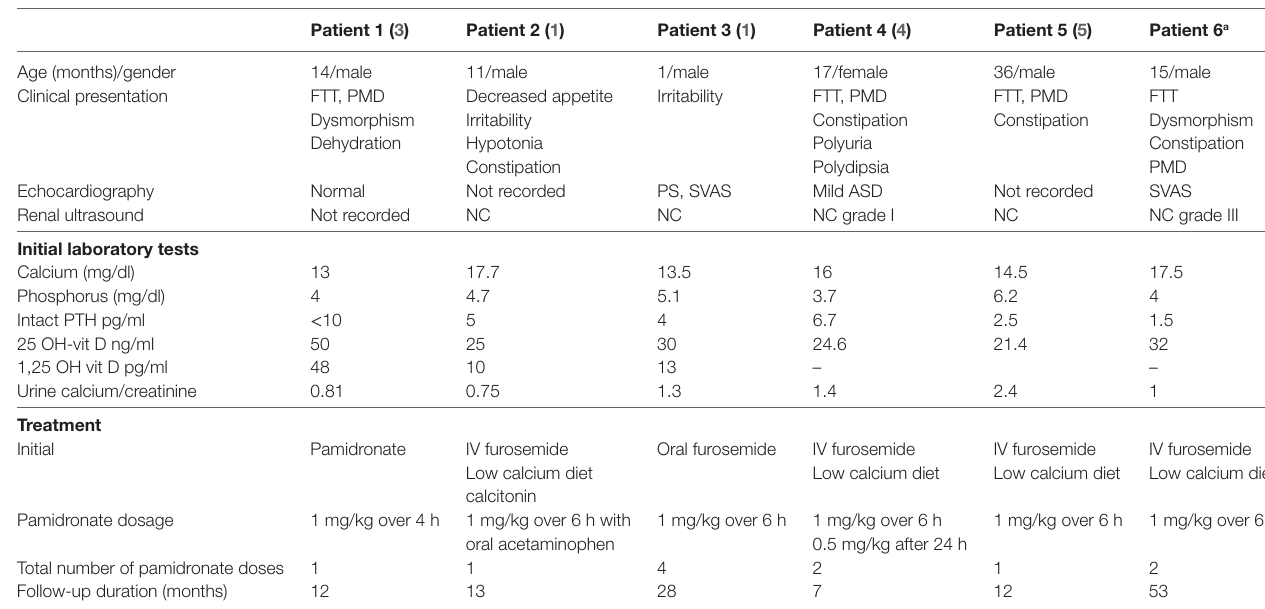
taBle 1 | Williams syndrome patients treated with